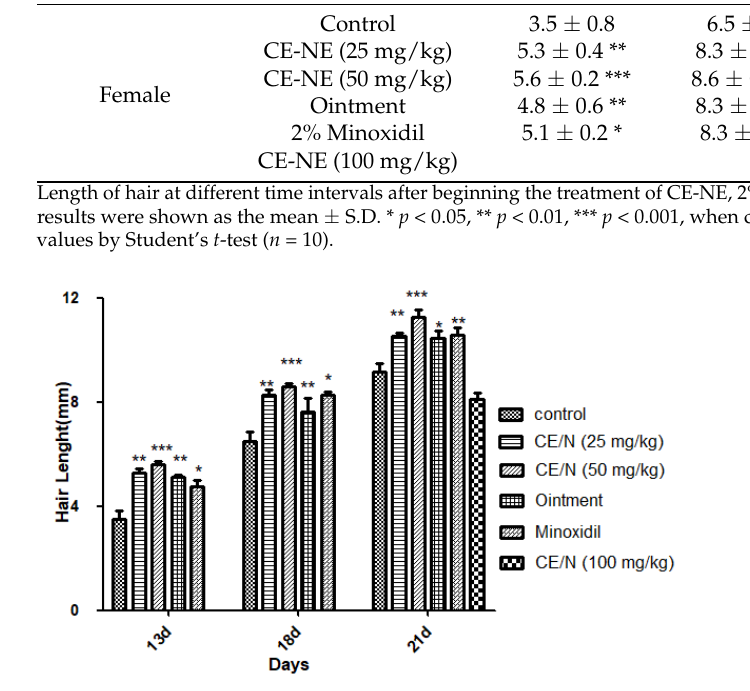
Figure 6. Hair length of mice at different time after beginning the treatment of CE-NE, 2% minoxidil and ointment. Results were showed as mean standard deviation (S.D). (* p < 0.05, ** p < 0.01, *** p < 0.001), compared with the control ( n = 10).